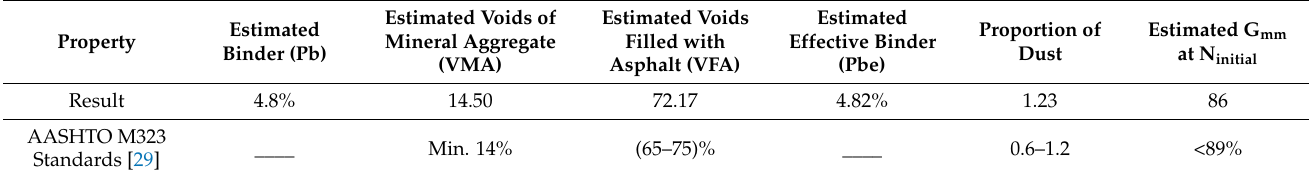
Table 11. The estimated volumetric properties of the trial